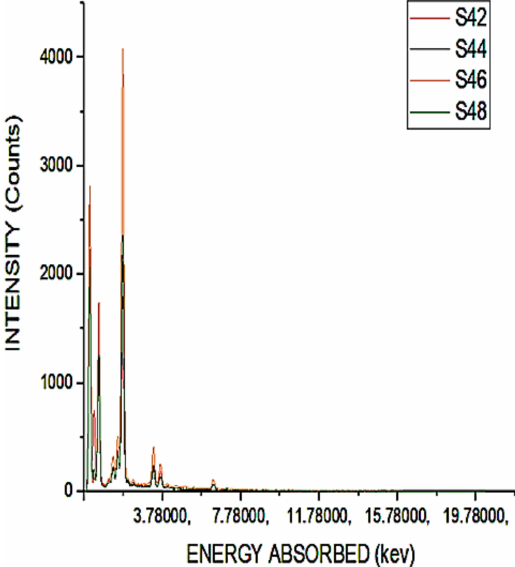
Figure 4. Chemical composition of S42 to